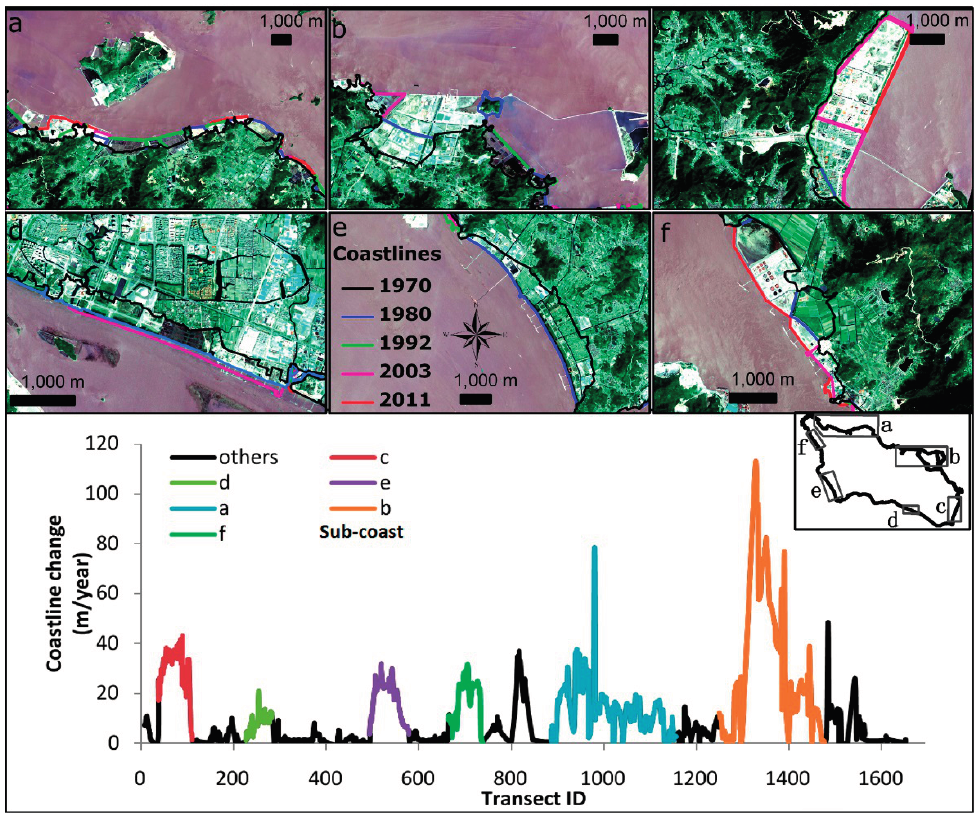
Figure 4. Coastline change rates along different transects of Zhoushan Island during the time period of 1970–2011. The six inserted squares are ( a ) the North of Xiaosha Town; ( b ) Baiquan New Port Industry District; ( c ) Donggang New Area; ( d ) Lincheng New Town; ( e ) Shuangqiao Lingang New Area, and ( f ) the Midwest of Cengang